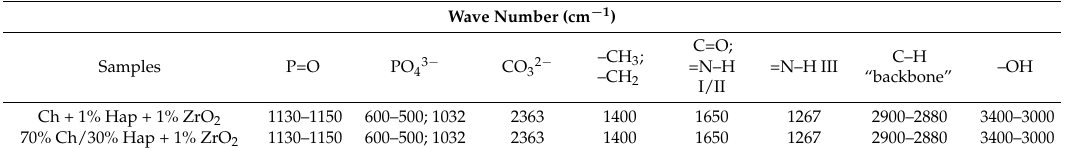
Table 2. The chemical bonds detected by FTIR spectrogram of composite chitosan/ceramic thin films.